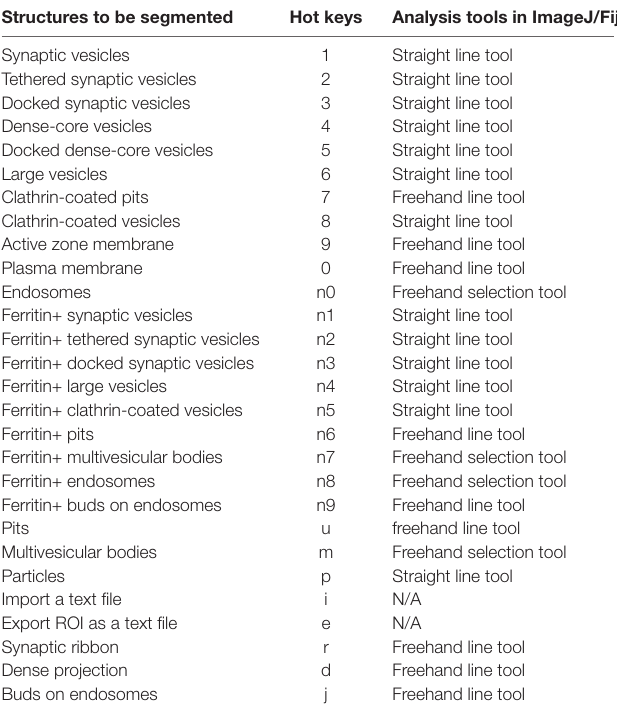
TABLE 2 | A list of hot keys, encoded in macros for ImageJ/Fiji. Structures to be segmented Hot keys Analysis tools in ImageJ/Fiji Synaptic